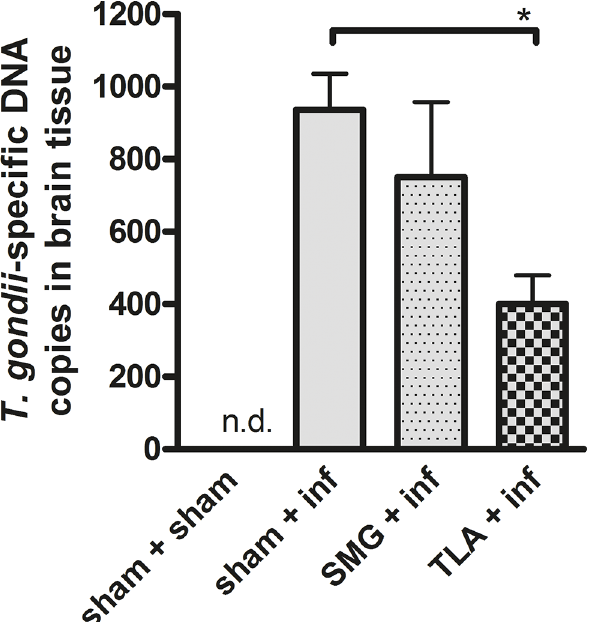
Fig 4. T . gondii -specific DNA copies in brain tissue. In systemically vaccinated and orally boosted brains were excised after infection on day 83. The number of T . gondii -specific DNA copies was determined in homogenised brain tissue by quantitative Real-time RT PCR. Bars represent mean ± SEM. Results represent data of two independent experiments. Data are expressed as mean ± SEM. * p < 0.05. (ND not